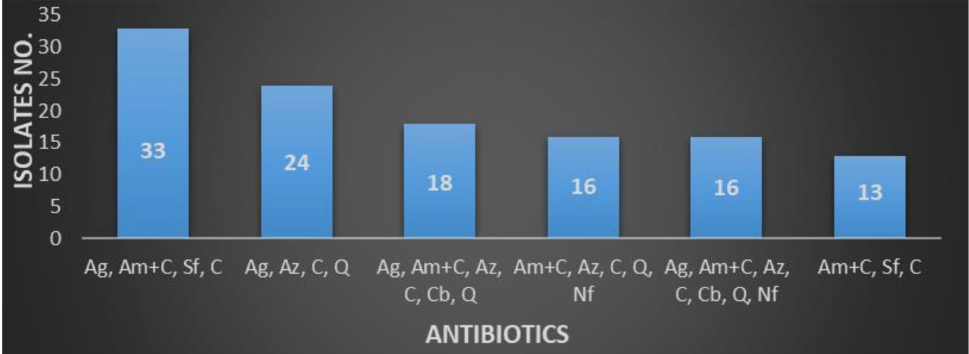
Figure 4. Klebsiella spp. resistance profiles of MDR strains (Ag—aminoglycosides, Am + C— aminopenicillins + β -lactams inhibitor, Az—aztreonam, C—cephalosporins,